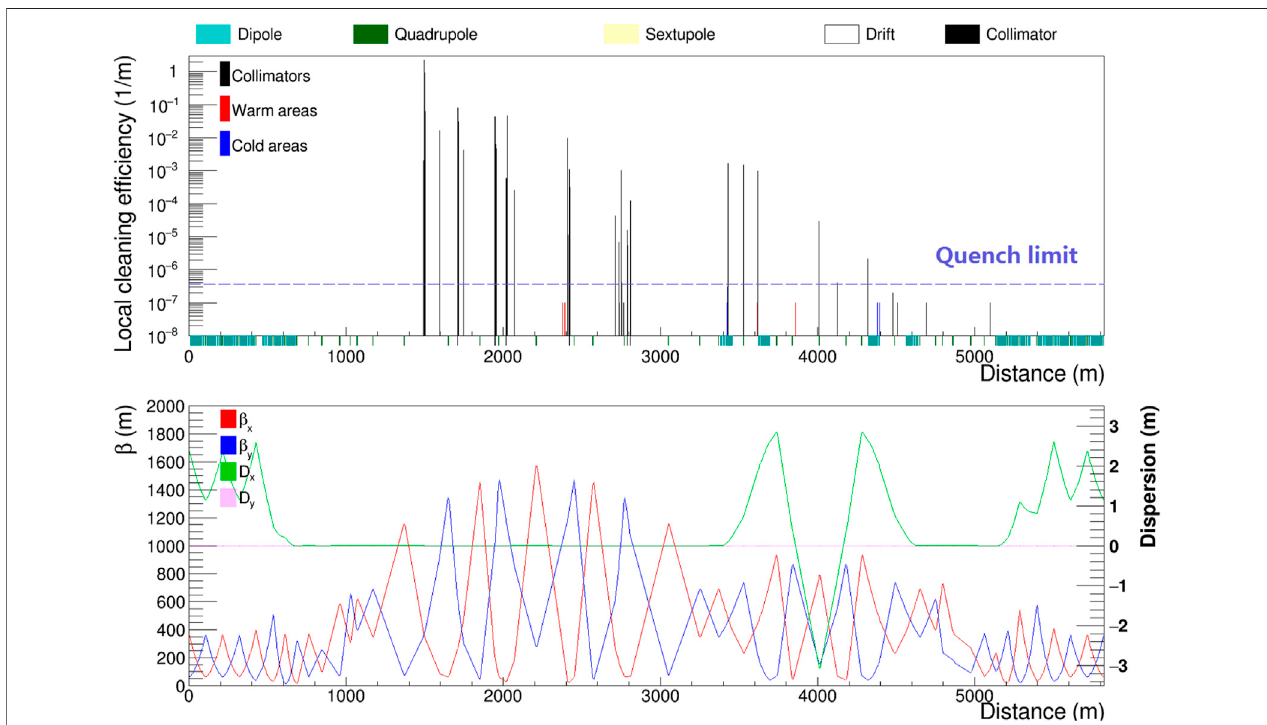
FIGURE 7 | Proton loss map in the collimation insertion with an initial vertical halo distribution (upper) and the lattice (lower).